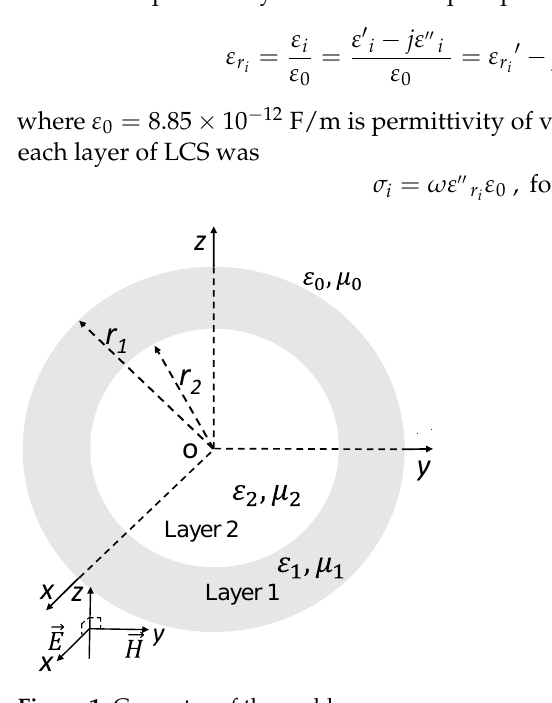
Figure 1. Geometry of the problem.